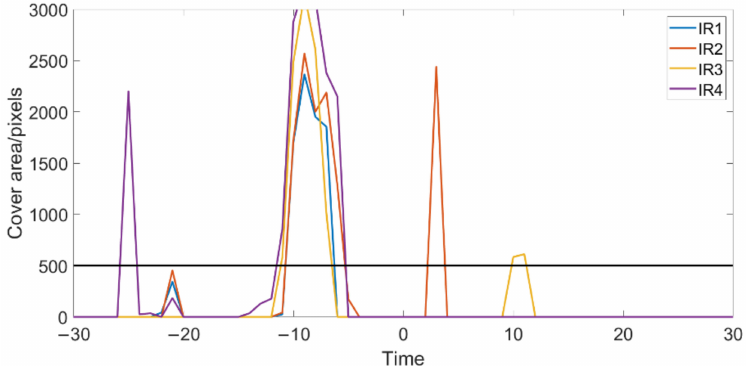
Figure 17. The cover area of the anomalies before and after Tibet